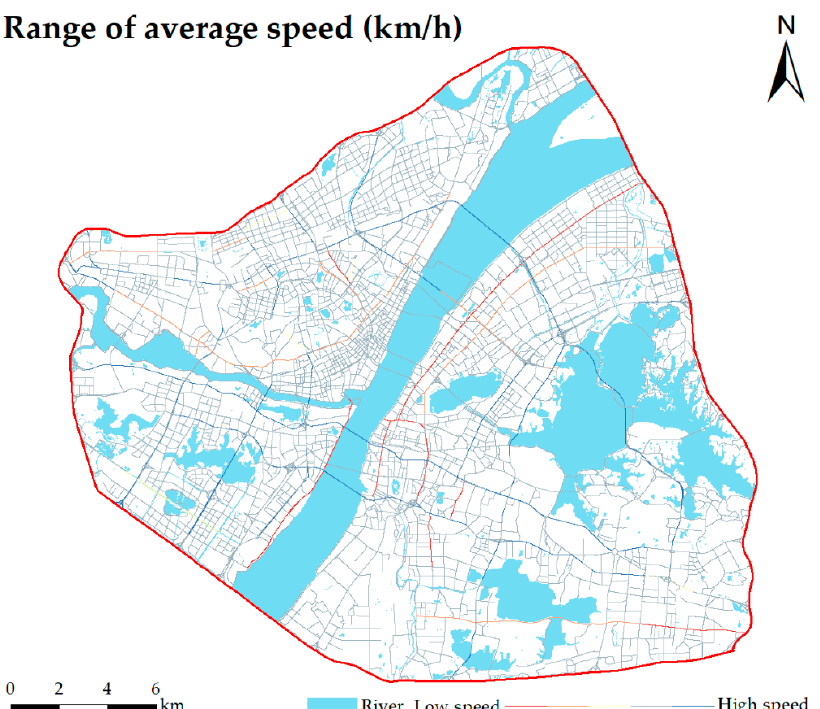
Figure 10. Average vehicle speed as a function of time.